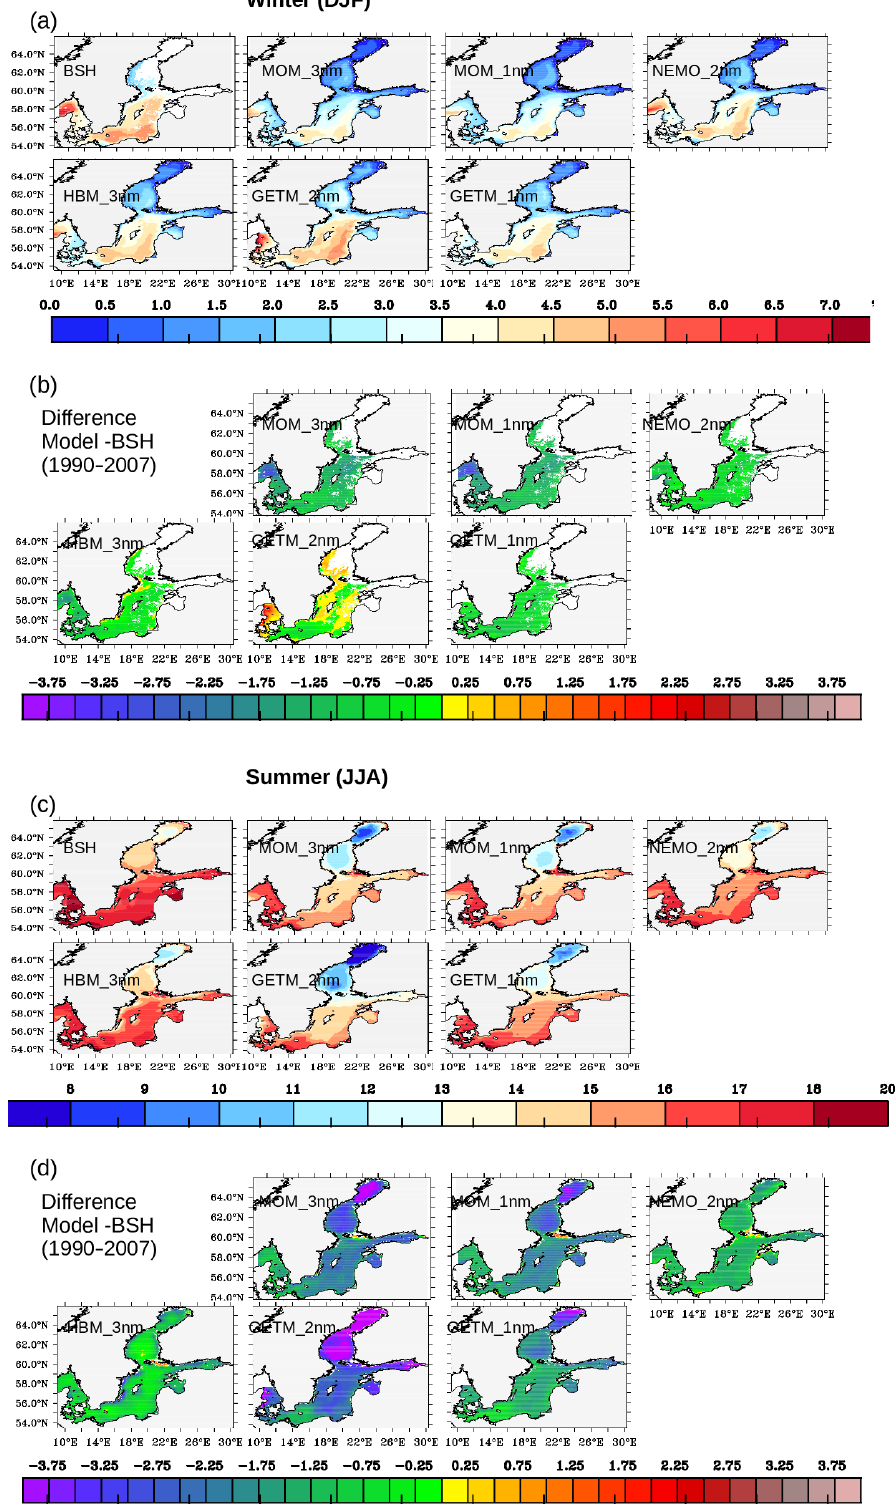
Figure 3. (a) Comparison of modeled winter SST with a satellite product from the Federal Maritime and Hydrographic Agency of Germany (BSH). (b) Difference between the models and the satellite product for winter. Panels (c) and (d) are as for panels (a) and (b) but for summer climatology. Note that winter SST coverage from the satellite product is